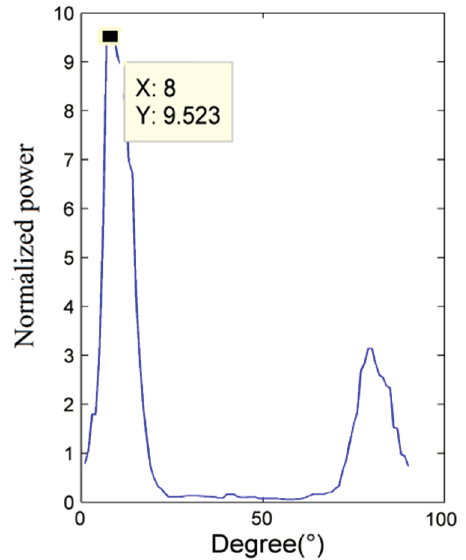
Figure 3. Angle-power